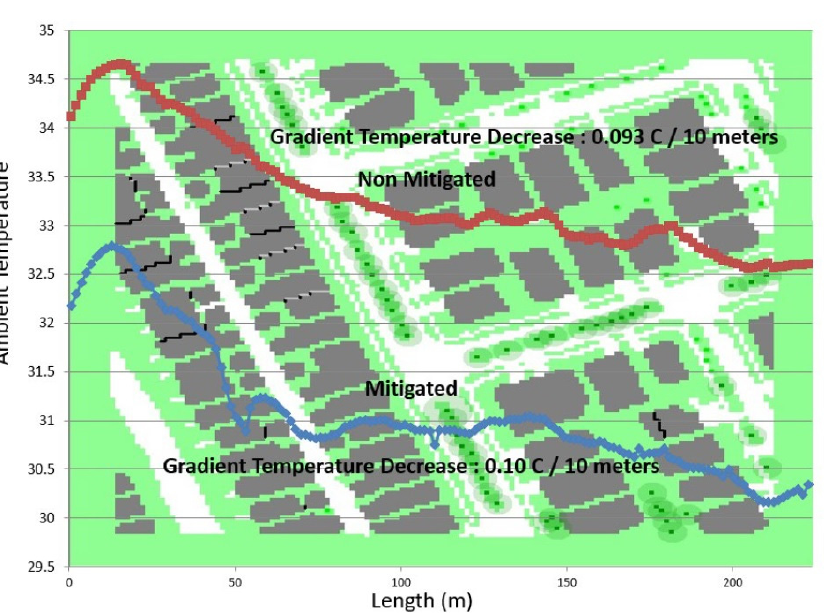
Figure 7. The GTD for the CT1 precinct for both mitigated and unmitigated scenarios is shown in the ENVI-met configuration.